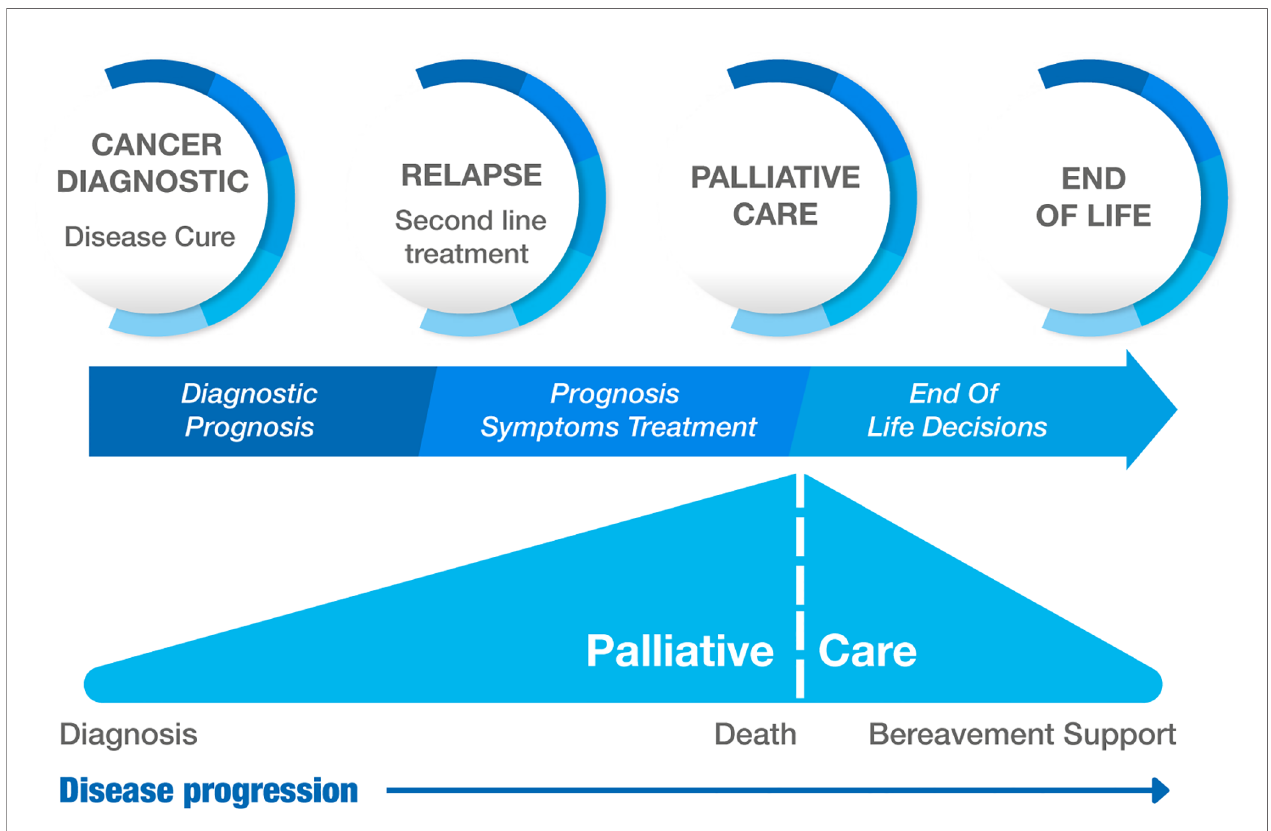
FIGURE 6 | Model of integrative palliative care in children with